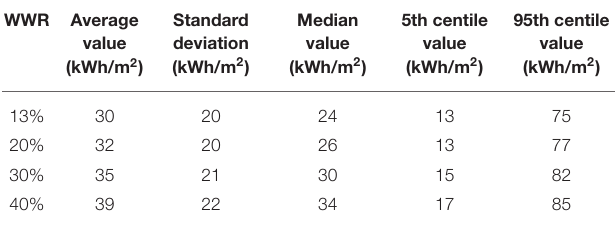
TABLE 2 | Statistical summary of the distribution of the annual heating demand for 1,000 occupant profiles when changing the window-to-wall